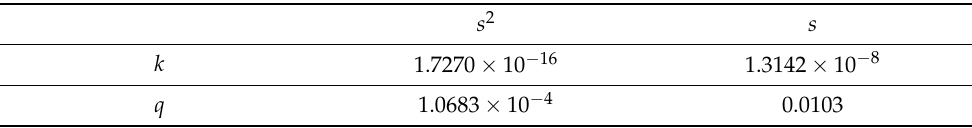
Table 4. Selection variances and errors of k and q parameters.